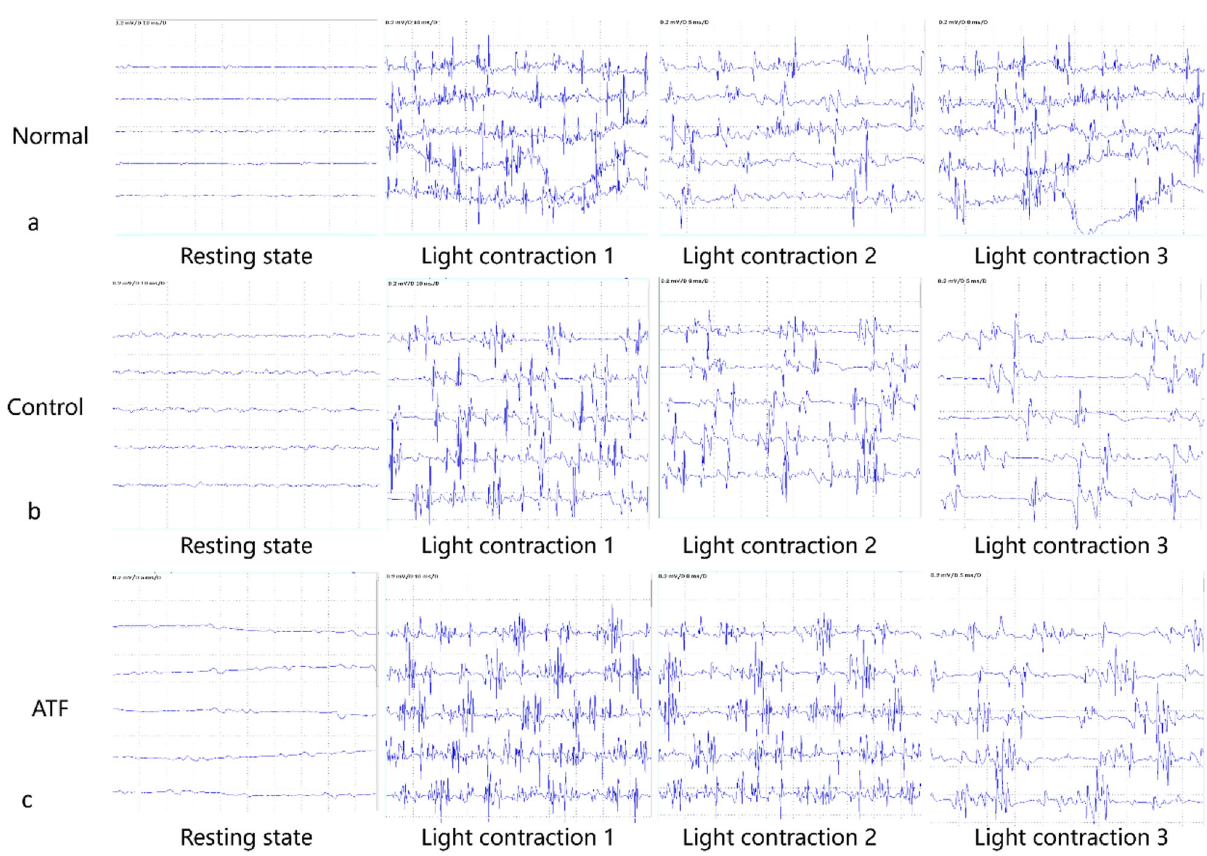
Fig. 3 EMG examination results of SD rats for paraspinal muscle function test. a EMG results of normal SD rats in resting state and awake light contraction state; b Control group EMG results showed more interference waves on the baseline without pathological wave